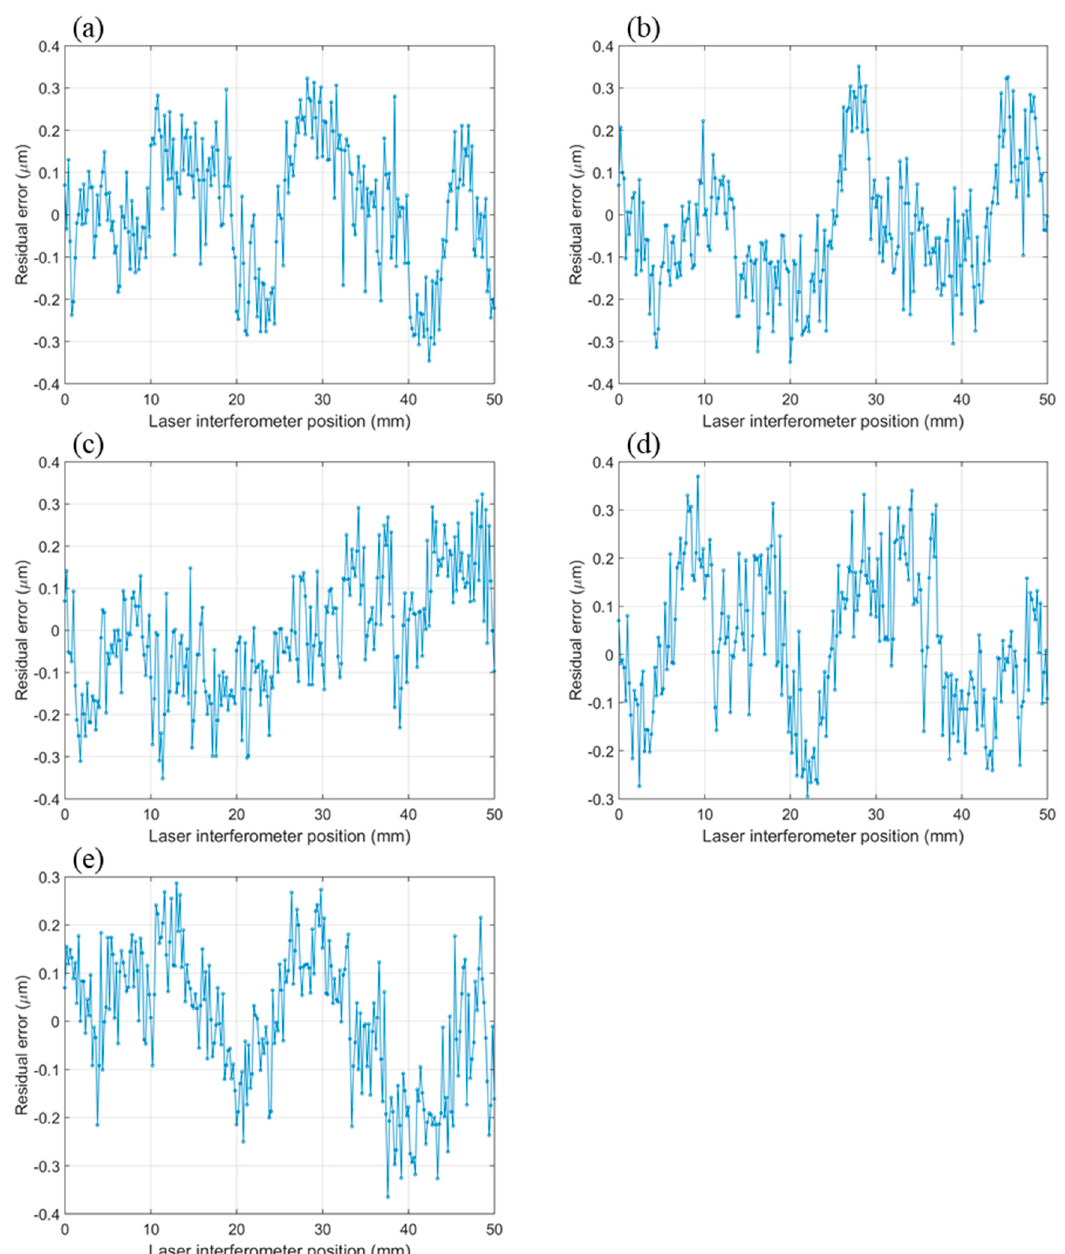
Figure 14. ( a )–( e ) Residual errors of repeated five measurement (50 mm). Figure 14. ( a – e ) Residual errors of repeated five measurement (50